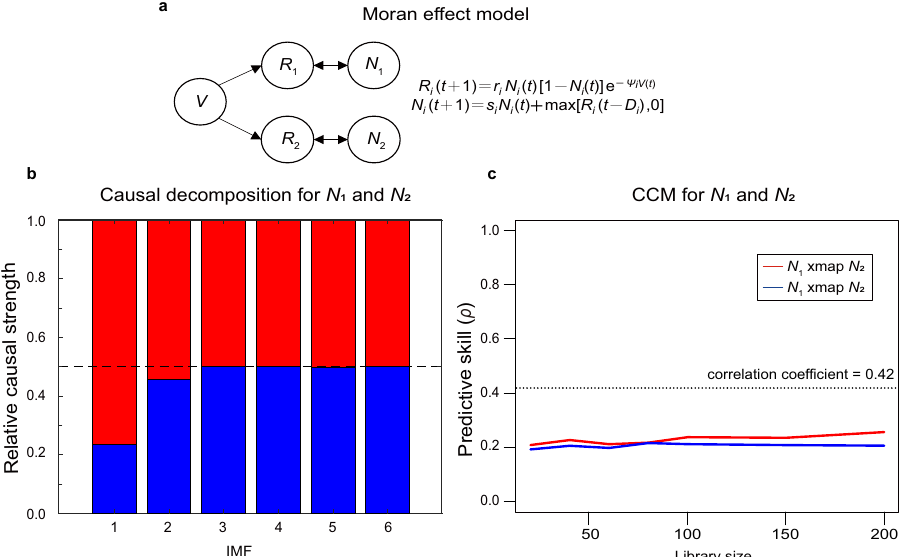
Fig. 1 Causal decomposition fails to falsify spurious causations presented in Moran effect model. a Moran effect model is a 5-variate difference equation model in which variables N 1 and N 2 have no causal relationship, but have a signi fi cant correlation in their time series due to shared external forcing, V . We ran this model for 10,000 time steps with the parameter set [ r 1 = 3.4, r 2 = 2.9, ψ 1 = 0.5, ψ 2 = 0.6, s 1 = 0.4, s 2 = 0.35, D 1 = 3, D 2 = 3, R 1 (0) = R 2 (0) = 1, N = N = 0.5], but retaining only the last 200 steps for analysis. Because of the strong correlation between N 1 (0) 2 (0) method, incorrectly concluded causation according to IMF 1 and 2, even though N 1 and N 2 do not interact. Here, causal decomposition is performed under 1000 ensemble EMD with noise level r = 0.085 selected based on the criteria of maximizing the separability but maintaining orthogonality of the IMFs, following the Matlab codes provided in Yang et al. 1 . In contrast, c CCM had no convergence (i.e., no improvement in CCM skill with increasing library size) in cross-mapping between N 1 and N 2 , and thus correctly concluded no causation between N 1 and N 2